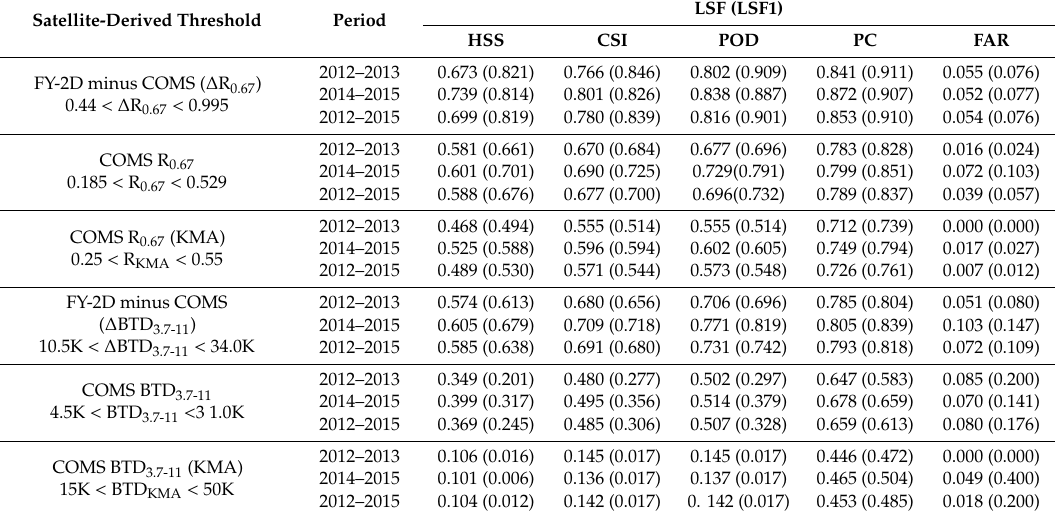
Table 4. Statistical verification of the six threshold values for LSF detection at dawn, using the FY-2D and COMS satellites. The values in parentheses below the LSF scores indicate the verification scores for LSF1 without the overlying higher clouds. The scores are presented for Period 1 (2012–2013), Period 2 (2014–2015), and the entire time period (2012–2015), respectively. The contingency table and definition are shown in Table